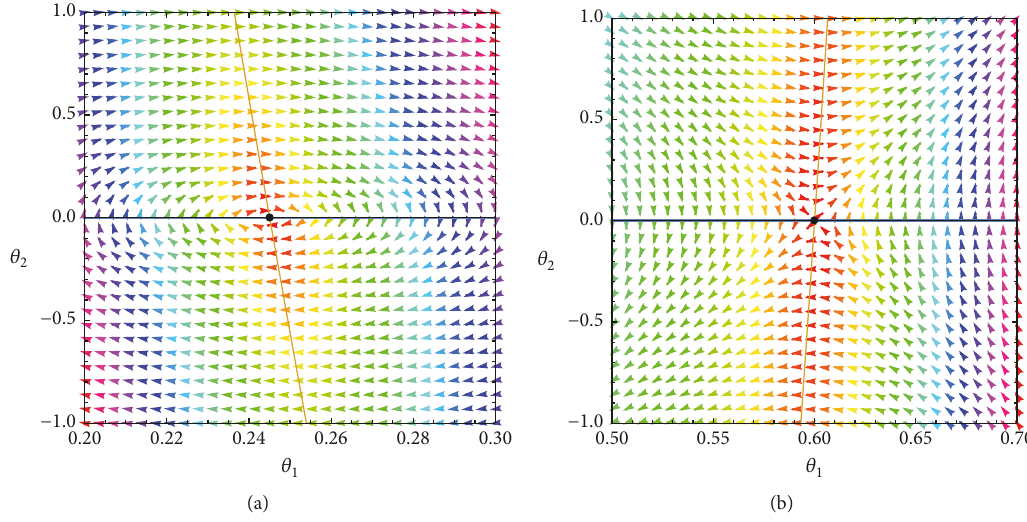
Figure 7: Phase plots indicating the trajectories around the equilibrium points (75) for 𝜃 𝑎 = 0.6 , 𝑟 ∗ = 1.75 , N 𝑐 = 100 , and N 𝑟 = 100 . (a) is a closer view of the second equilibrium point for the alternate